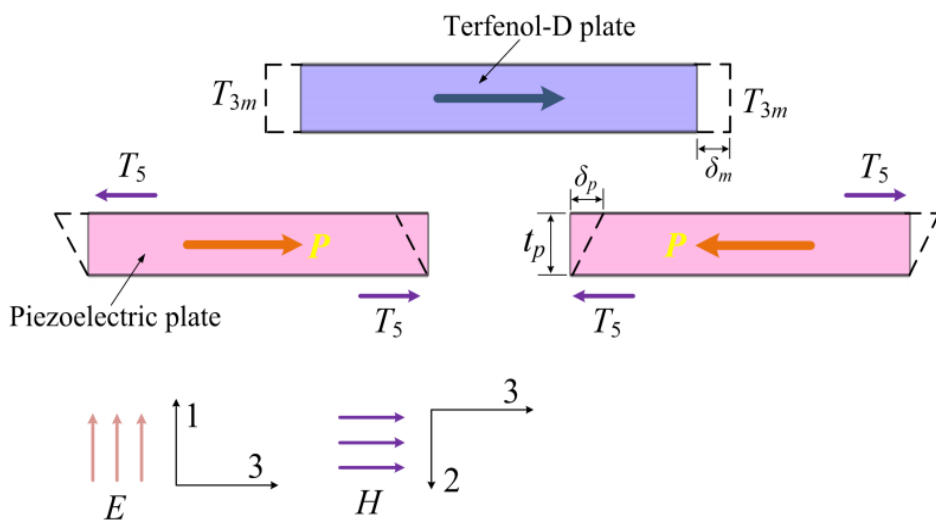
Figure 2. Deformations of the Terfenol-D plates and the piezoelectric plates under operation. After bonding a high-permeability film on the surface of the Terfenol-D plate, the internal effective magnetic field of the magnetostrictive plate can be expressed as